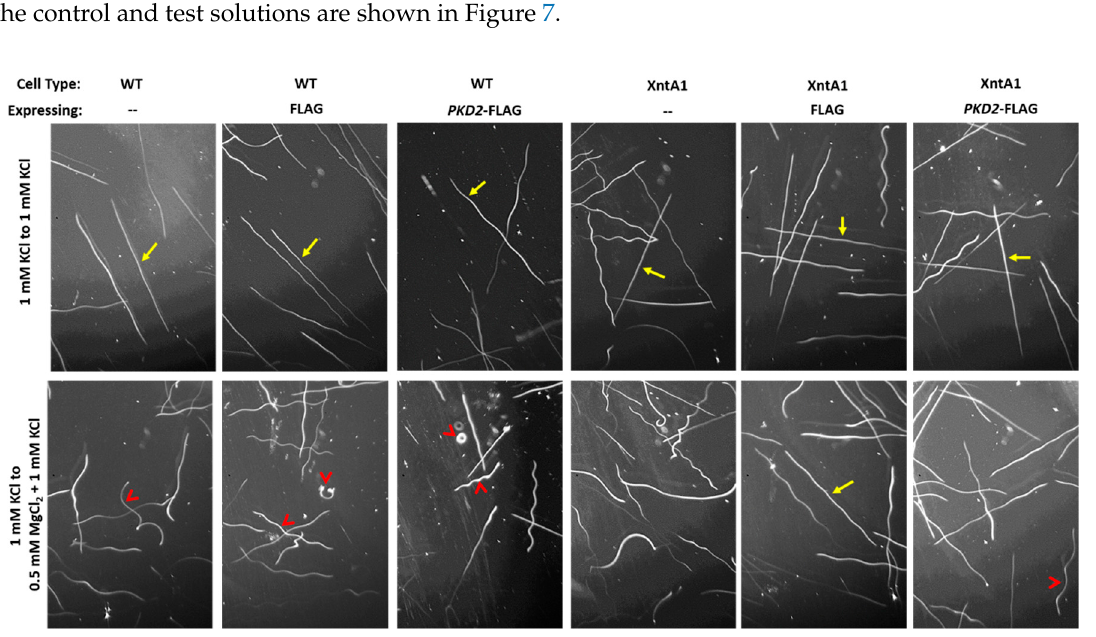
Figure 7. Representative swimming trace images of WT and XntA1 mutant cells and those cells over-expressing FLAG or PKD2 -FLAG as the cells enter 1 mM KCl (control solution) or 0.5 mM MgCl 2 with 1 mM KCl (test solution) from a 1 mM KCl solution. Cells were imaged in a dark field illuminated from the side using a 2.5 second exposure to appear white on a dark background. Traces were measured using ImageJ [68] and converted to mm/sec. Yellow arrows show straight, forward swimming traces, while red arrow heads show slower swimming traces with more turns.